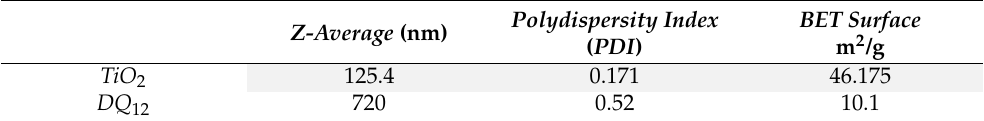
Table 1. Summary of primary characterisation data [53,54,56].